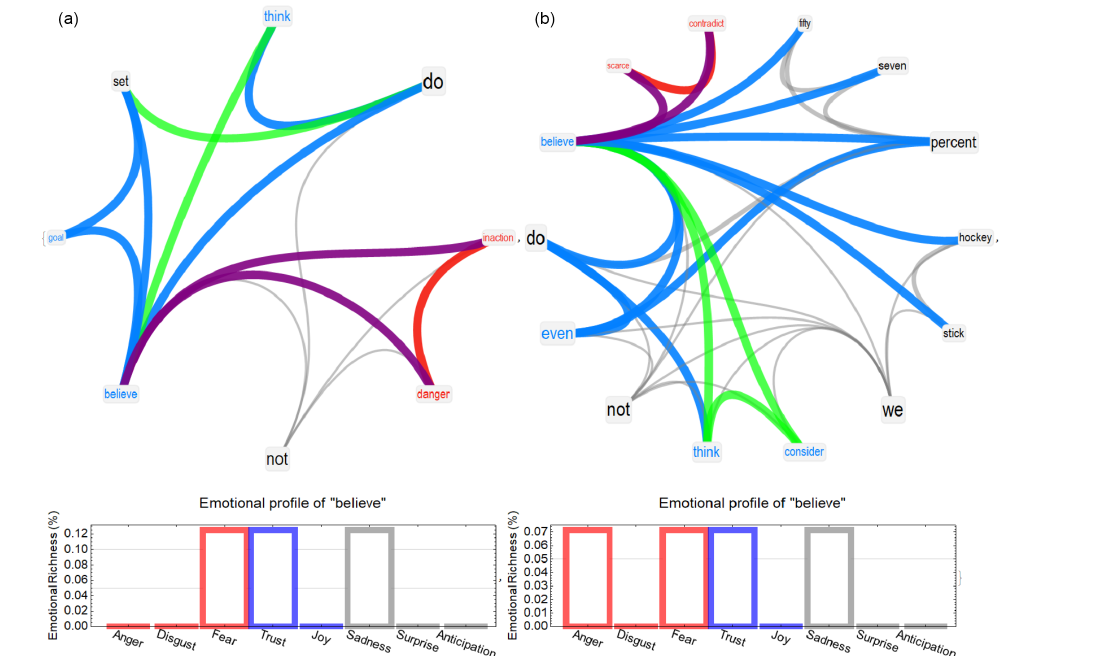
Figure A6. Speakers’ mindset reconstruction around “believe” in the speeches of Greta Thunberg (a) and Christopher Monckton (b) . We refer the reader to Fig. 1 for a detailed explanation of the colour code and to Lexicon 1 for an interpretation of the figure.